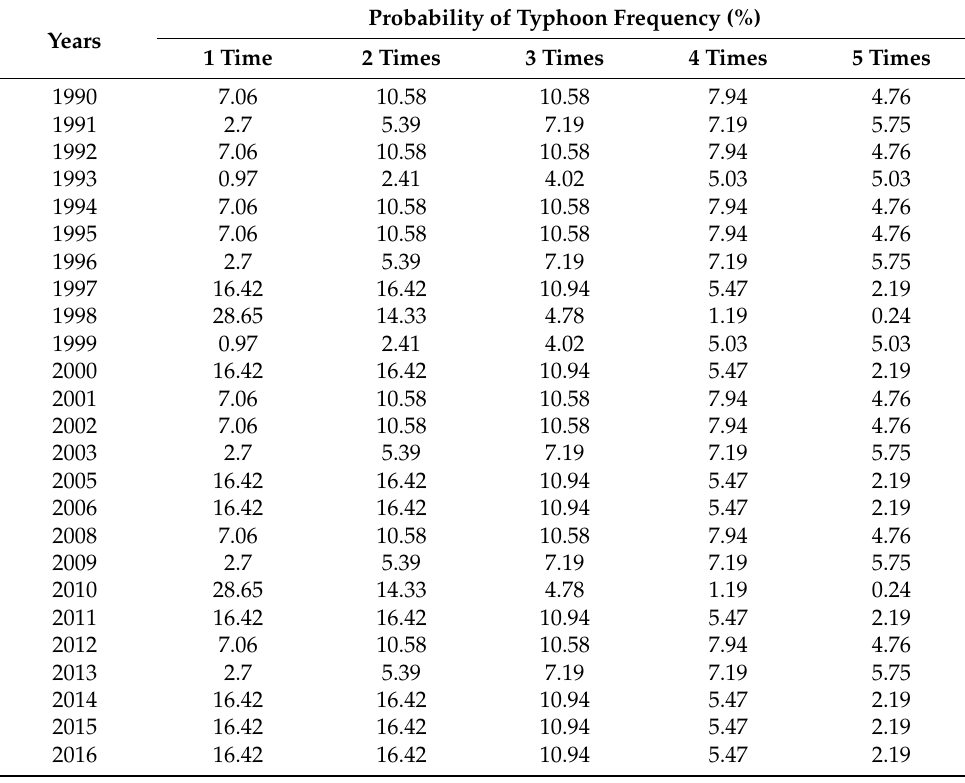
Table 2. Probability of each occurrence frequency of typhoon from June to September.